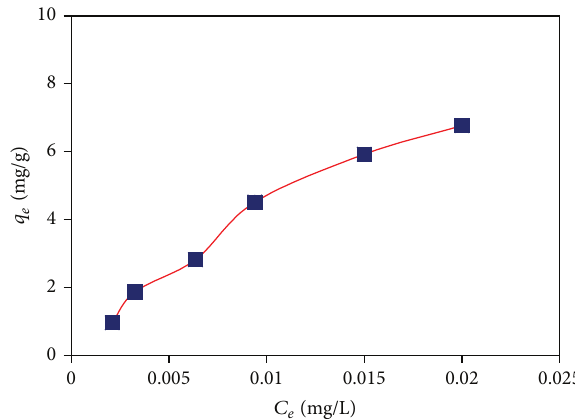
Figure 6: Equilibrium curve for the adsorption of Hg 2+ on